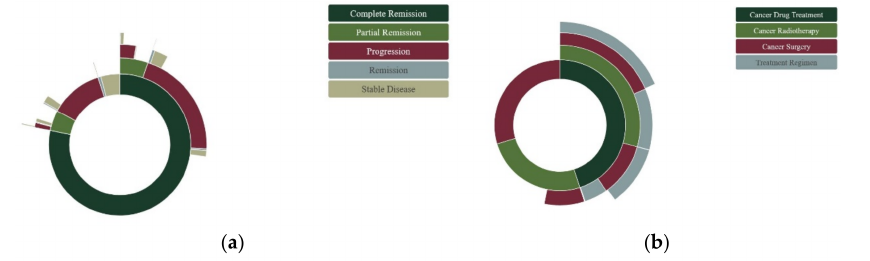
Figure 3. ( a ) Sunburst plot of Disease Dynamic concepts. The segmented pie chart shows the first to fourth remission status of all patients in the Episode Domain. ( b ) Sunburst plot of Treatment concepts. The segmented pie chart shows first to fourth line therapies of all patients in the Episode Domain.